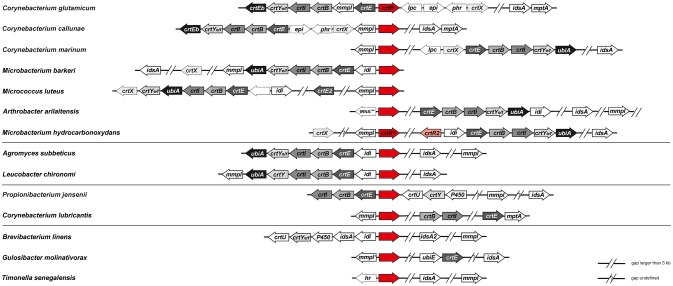
Co-occurrence of homologs of C. glutamicum crtR with genes of carotenogenesis in various completely sequenced genomes. The genetic organization of crtR homologs and genes relevant for carotenoid biosynthesis is depicted for representative genomes containing a crtR homologue and at least one gene of carotenogenesis (s. also Figures S1, S3). crtR, regulator of carotenoid biosynthesis and its homologs (in red); crtE/idsA, geranygeranyl diphosphate synthase; crtB, phytoene synthase; crtI, phytoene dehydratase; crtYe/f, C50 epsilon cyclase; crtEb, lycopene elongase, crtX, carotenoid glycosyl transferase, mmpl, putative RND drug exporter; mmpl', pseudogene with homology to mmpl; lpc, putative lipocalin; phr, putative deoxyribopyrimidine photolyase; epi, putative NDP sugar epimerase; idi, isopentenyl diphosphate isomerase; crtEb/ubiA, prenyltransferases; P450, cytochrome P450 monooxygenase; mptA, α(1→6) mannopyranosyltransferase; ubiE, ubiquinone biosynthesis methyltransferase; crtU, β-carotene desaturase/isorenieratene synthase; crtY, lycopene cyclase (no significant homology to CrtYe/f from C. glutamicum); hr, hemerythrin.